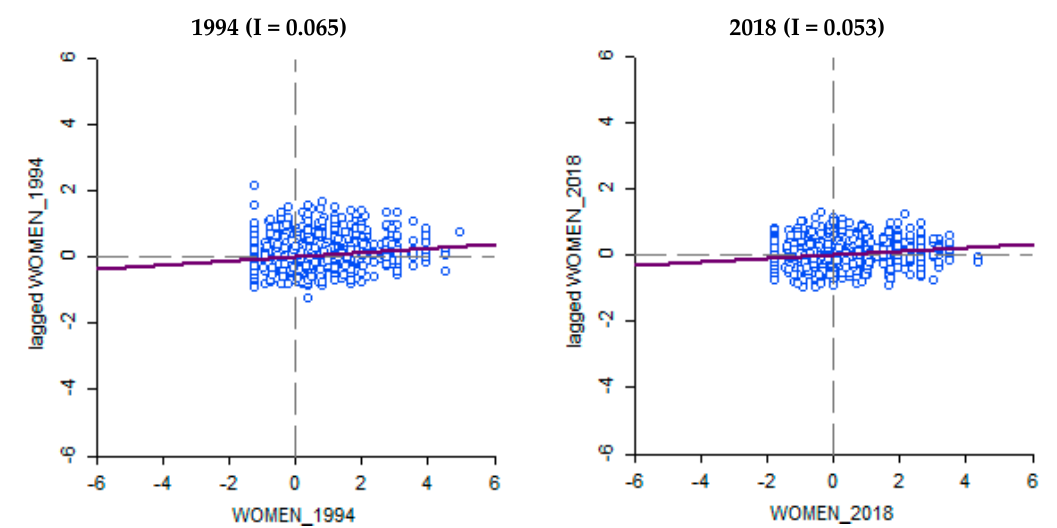
Figure 1. Moran scatterplots for women’s descriptive representation in Czech local councils, 1994 and 2018. Source: Czech Statistical Office; own calculation. Note: Moran’s I is calculated based on spatial weights with a fixed Euclidean distance for the threshold distance of 10 km. All values are statistically significant at the 5% significance level based on 999 permutations.